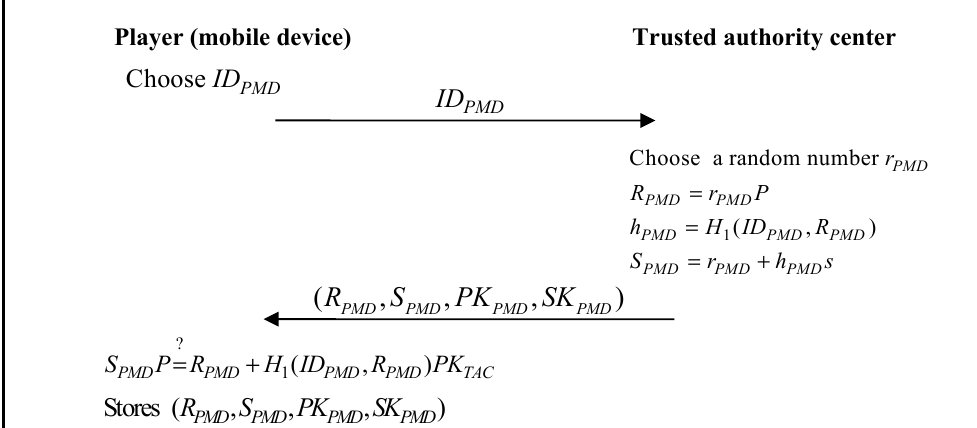
Figure 3. Player (mobile device) registration phase of the proposed scheme.